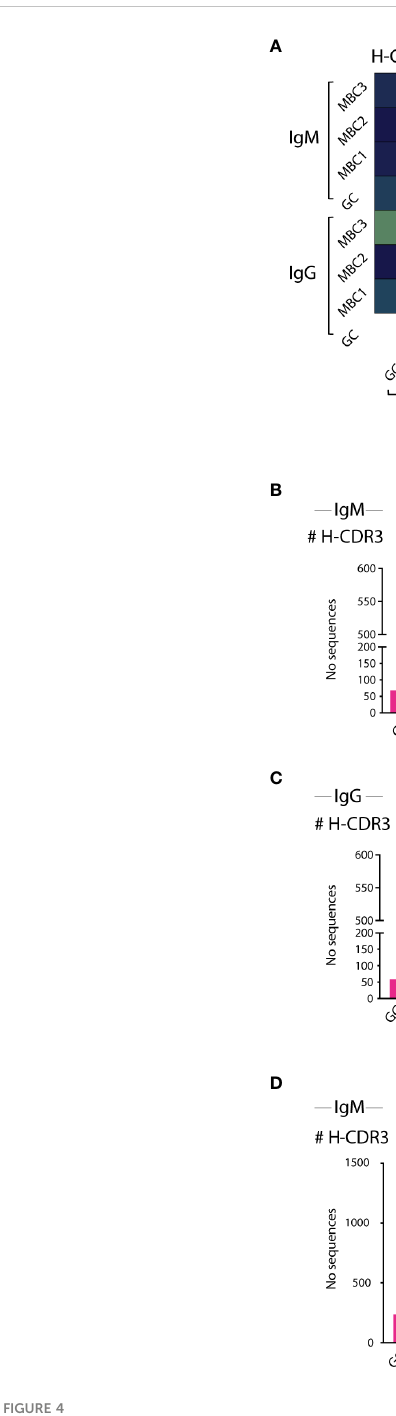
(Figures 6A – C, 7A). These four clones contained sequences from all populations. Some of the sequences from one population overlapped (orange nodes) with that of another, i.e., they shared the same sequence. In fact, at some nodes, at least three of the populations overlapped, for instance GC B cells and two of the MBC subsets or the three MBC subsets, which we observed for both IgM